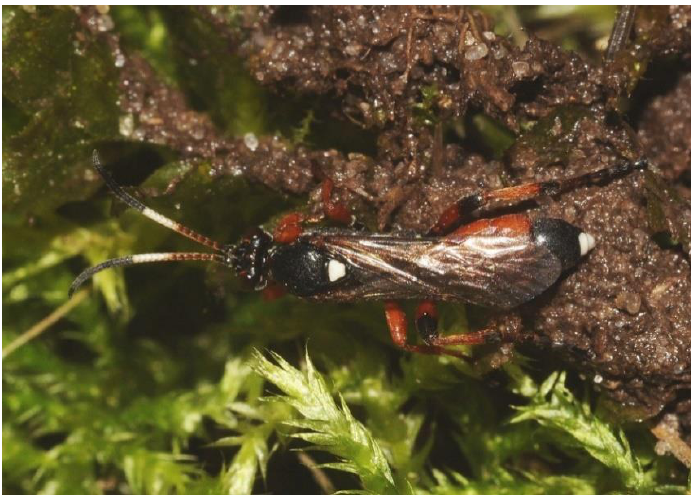
Figure 7. A female Ichneumon cf. eumerus reared from a pupa of Phengaris alcon.